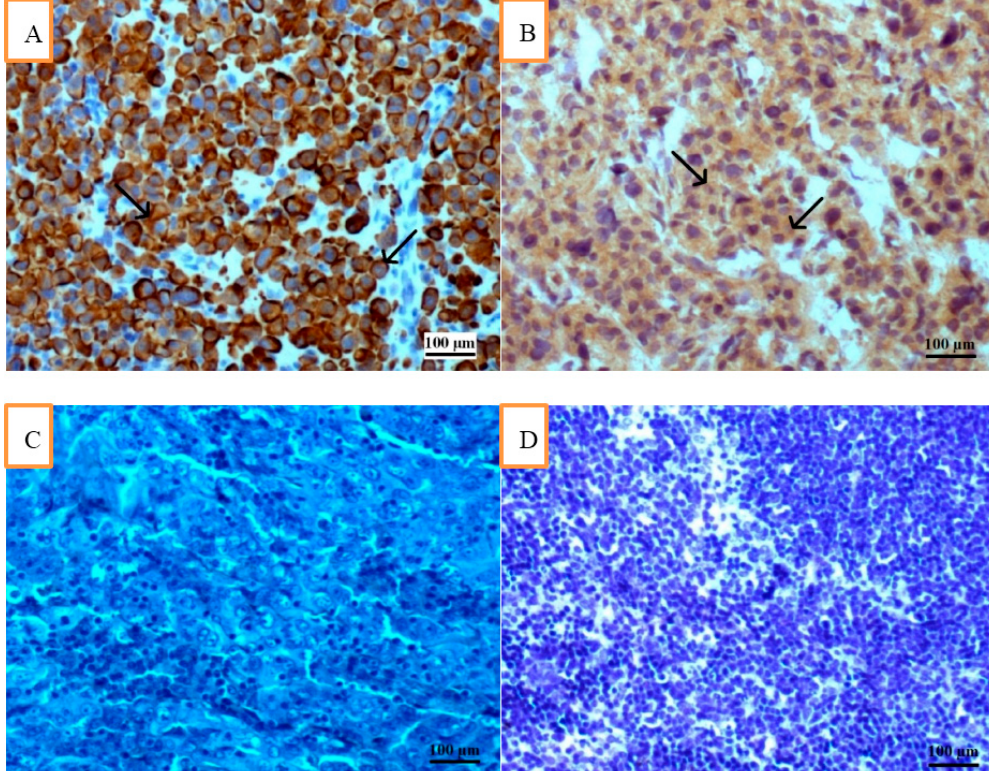
Figure 1. ( A ) Sentinel lymph node from the patient with metastatic breast invasive carcinoma NST G2. Immunohistochemical staining for cytokeratin 19 (streptavidin-biotin method, hematoxylin counterstained, 100×). Positive reactions have been observed in metastatic carcinoma cells (arrows); ( B ) Sentinel lymph node from the patient (same as in Figure 1A) with metastatic breast invasive carcinoma NST G2. Immunohistochemical staining for matrix metalloproteinase-9 (streptavidin-biotin method, hematoxylin counterstained, 100×). Positive reactions have been observed in cytoplasm of metastatic carcinoma cells (arrows); ( C ) Negative control. Sentinel lymph node from the patient with metastatic breast invasive carcinoma NST G2. No immunostaining was found. First antibody was omitted in this case; hematoxylin, 100×; ( D ) Negative control in normal lymph node from breast cancer-free patient. Staining for matrix metalloproteinase-9 (streptavidin-biotin method, hematoxylin counterstained, 100×) revealed no reactivity in this case.